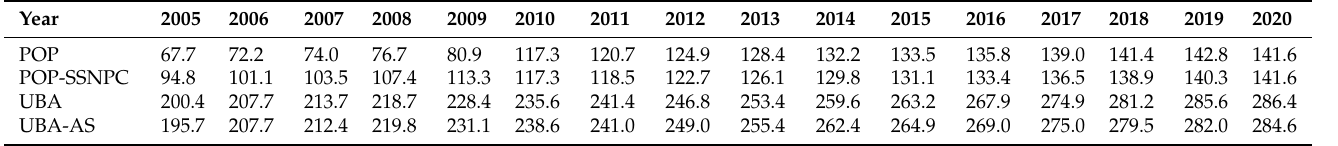
Table 2. Allometric scaling analysis of population size and urban area in Jinjiang from 2005 to 2020.